Question: Sum up the contents of this chart in one sentence.
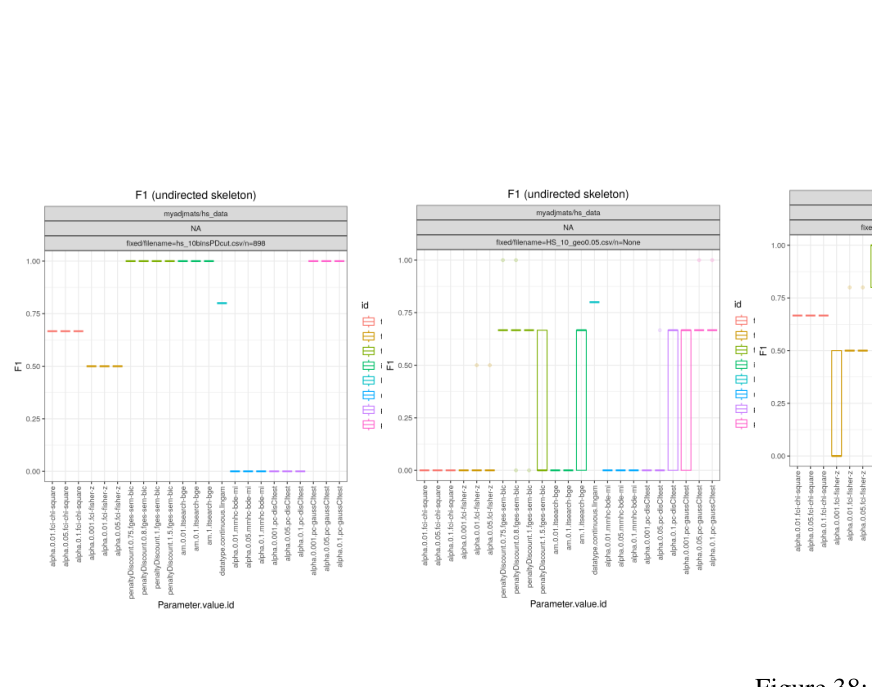
Answer: F1 Scores on the Human Stature data set. Dis- cretized, no noise.